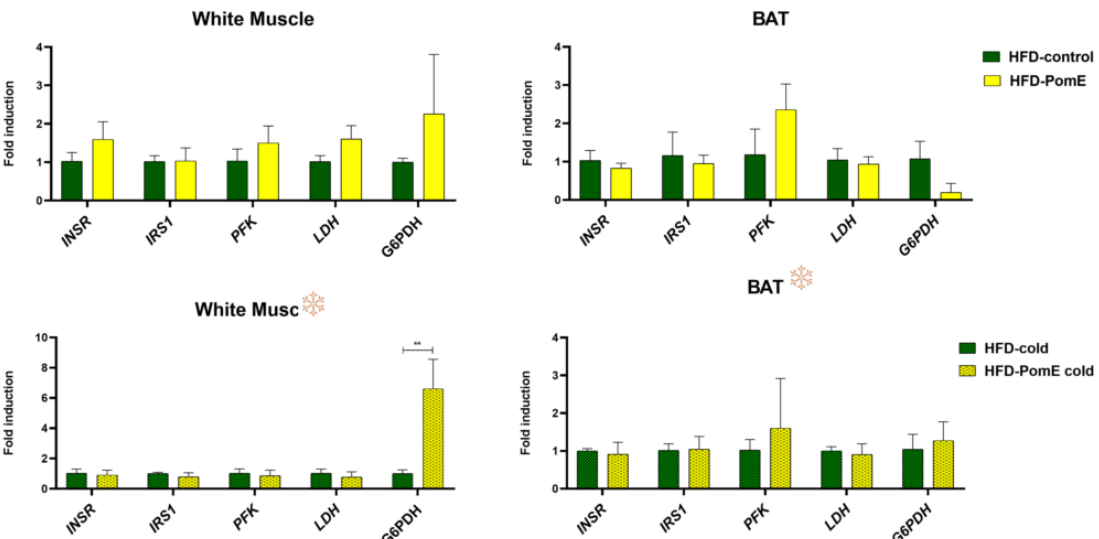
Figure 8. Gene expression levels of genes related to glycolysis and redox homeostasis in brown adipose tissue (BAT) and in the white muscle tissues of HFD-control and HFD-PomE groups, exposed or not to cold stress (N = 4–8). Statistically significant values are indicated with asterisks based on their p -value, ** p < 0.01.